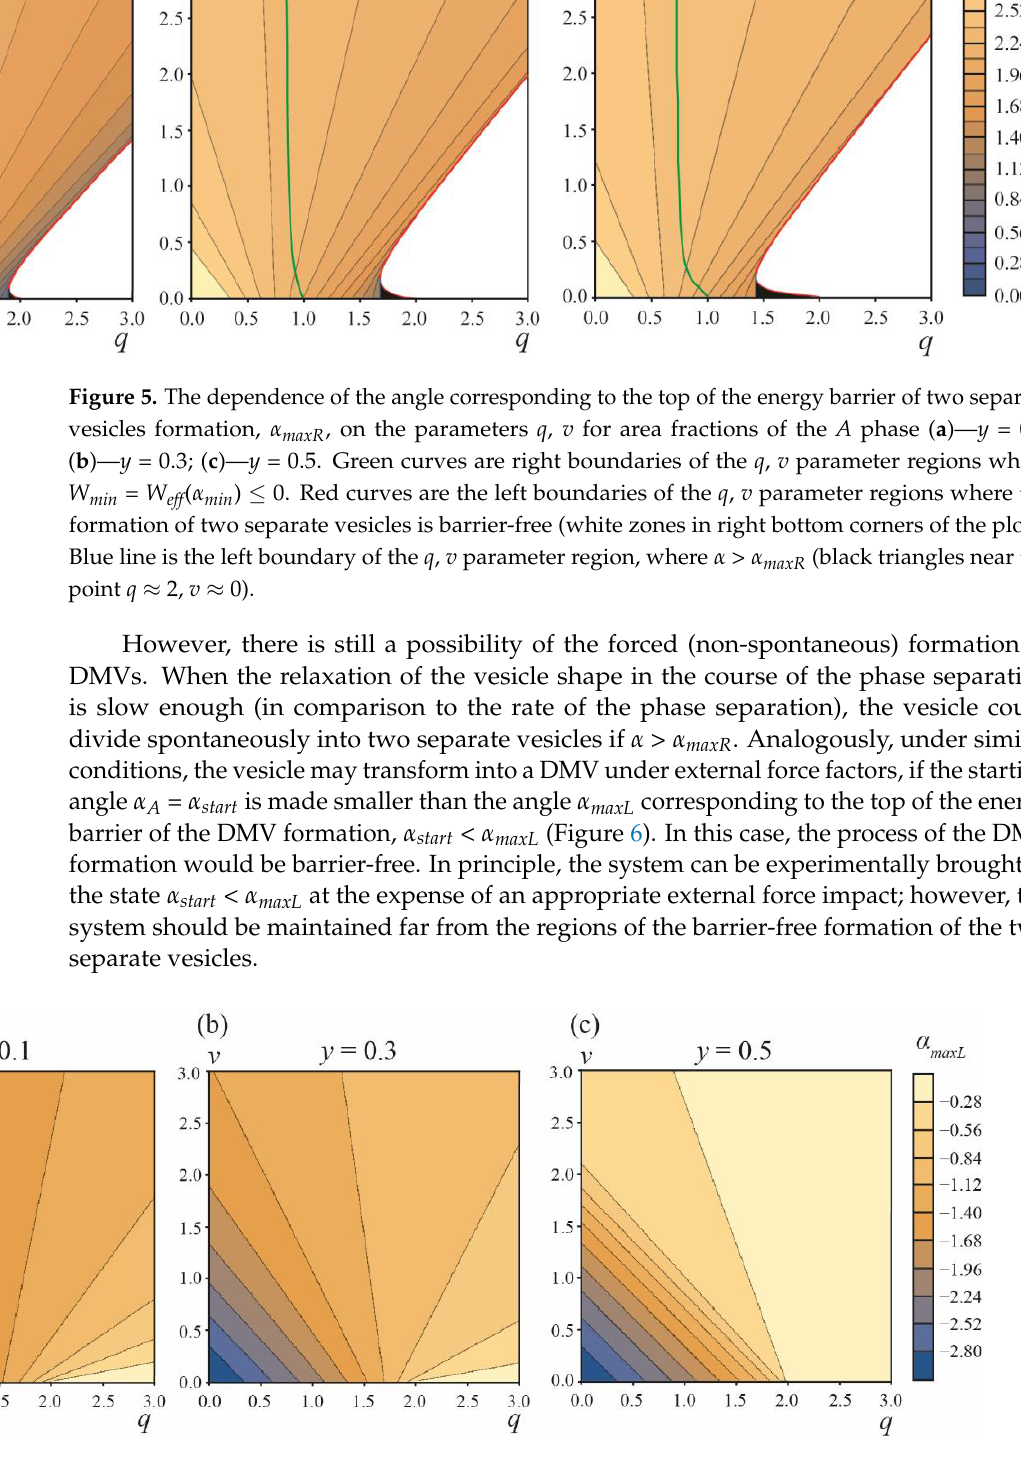
Figure 6. The dependence of the angle corresponding to the top of the energy barrier of the DMV formation, α maxL , on the parameters q , v for area fractions of the A phase ( a ) — y = 0.1; ( b ) — y = 0.3; ( c ) — y = 0.5.